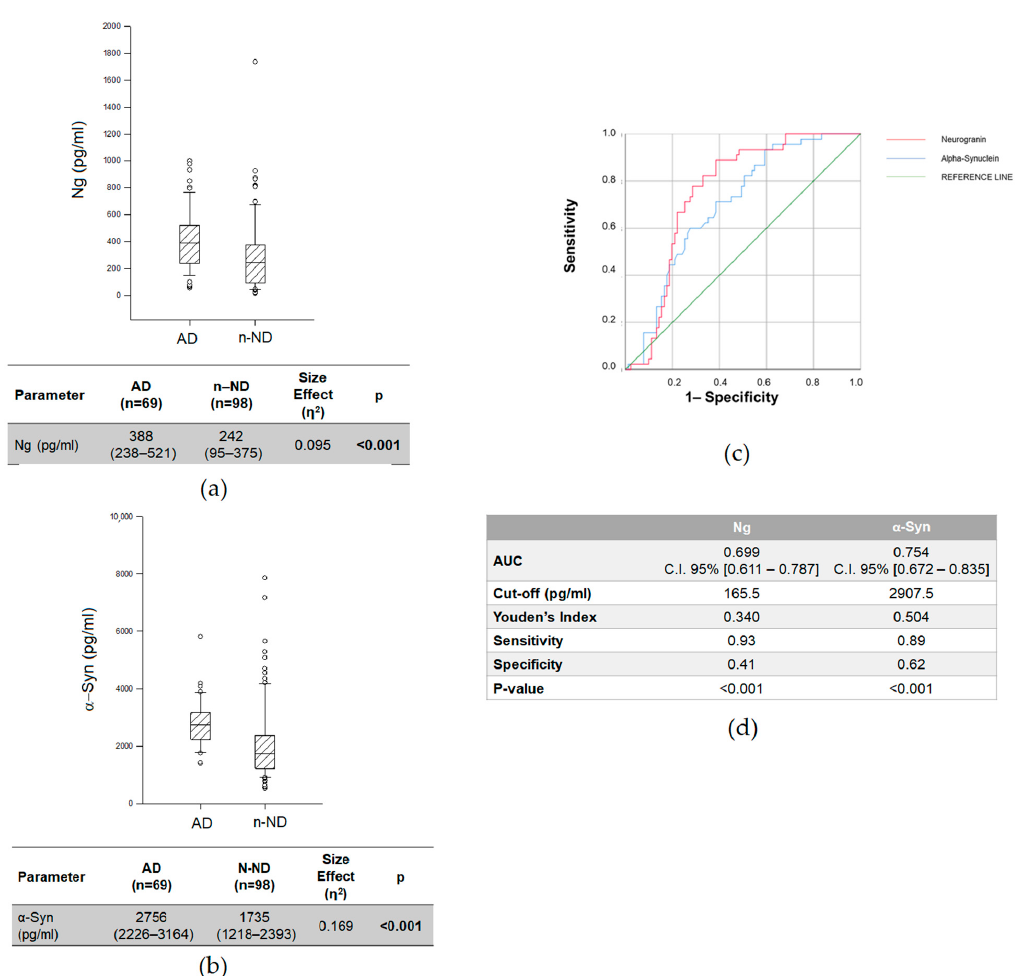
Figure 1. CSF Ng ( a ) and α -Syn ( b ) levels in AD and n -ND patients. Data are expressed as